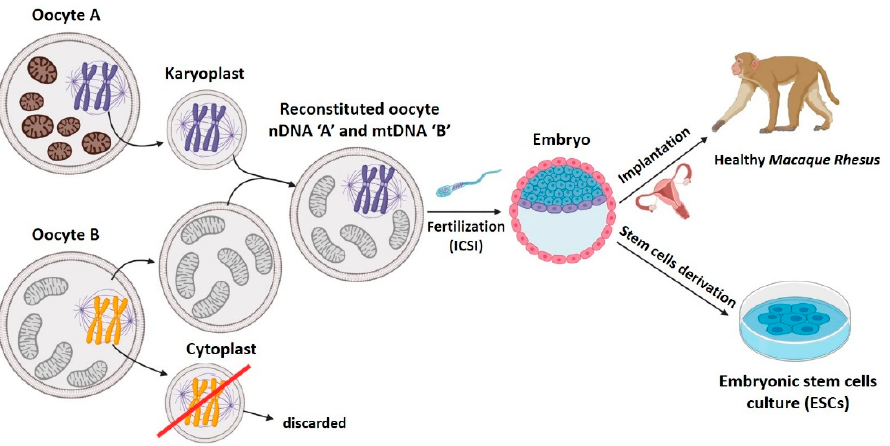
Figure 4. The meiotic spindle transfer technique described by Tachibana et al. [19] in 2009 that would be employed, with modifications, in many later works. Created with